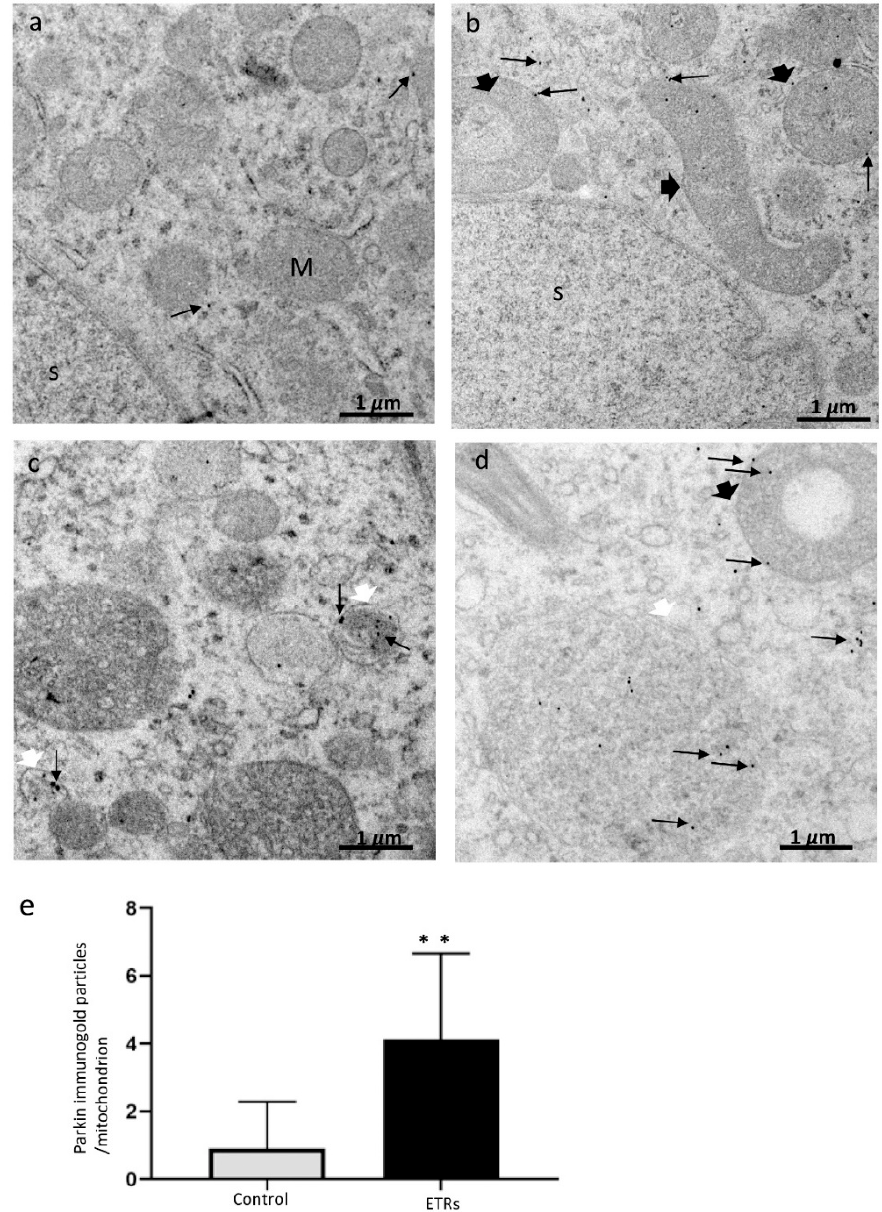
Figure 5. Ultrastructural characteristics of Parkin overexpression and mitochondrial translocation in ETR SCs. ( a ) control; ( b – d ) ETRs. The long black arrows mark Parkin immunogold particles, while the short black arrows indicate damaged mitochondria. The white arrows mark the autophagosomal membrane. S: SC nucleus; M: normal mitochondria. ( e ) Histogram demonstrating significant increase in the number of Parkin immunogold particles in the mitochondria of ETRs SCs compared to control. ** p < 0.01 ( t -test).